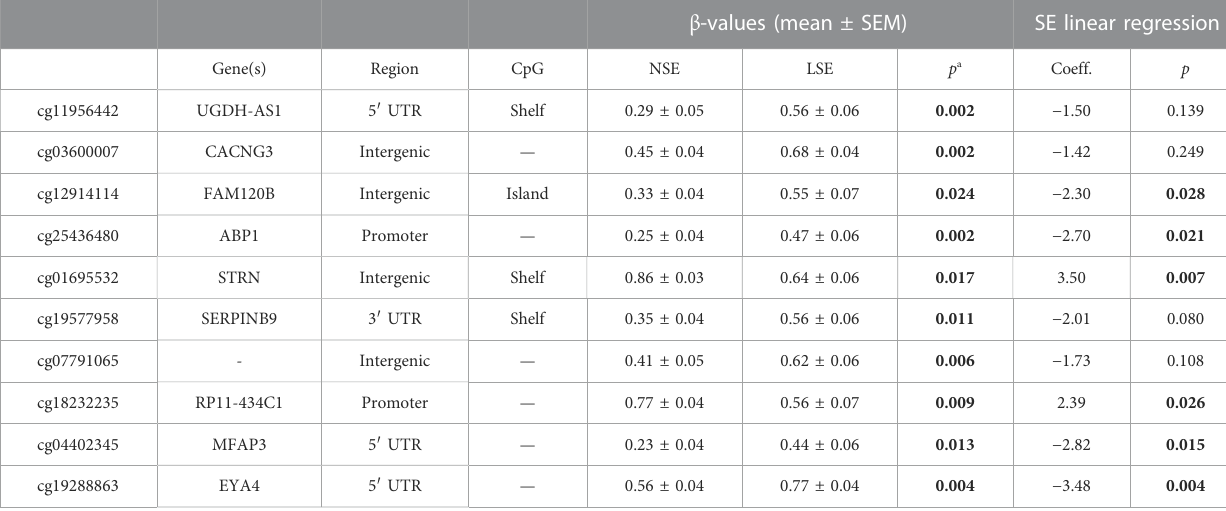
TABLE 4 Intergroup comparisons and linear regression between SE scores and respective β -values of 10 most differentially methylated loci (DML). β -values (mean ± SEM) SE linear